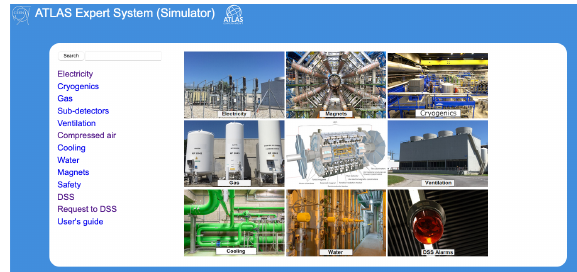
Figure 1. Expert System welcome